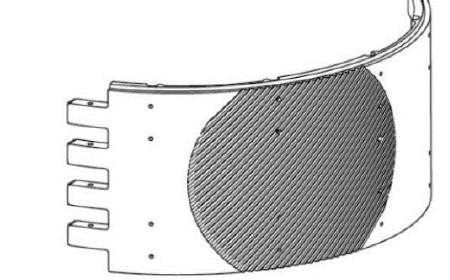
Fig. 7. Centre column polarising tile